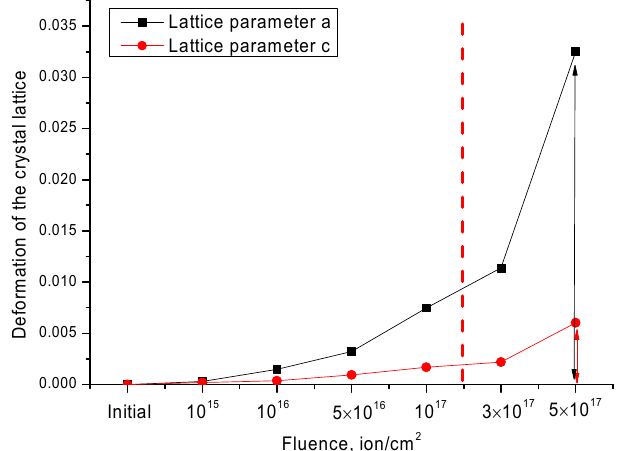
Figure 8. The results of deformation of the crystal lattice of SiC ceramics depending on the ra- diation dose (the red dotted line indicates the boundary after which an exponential increase in deformation